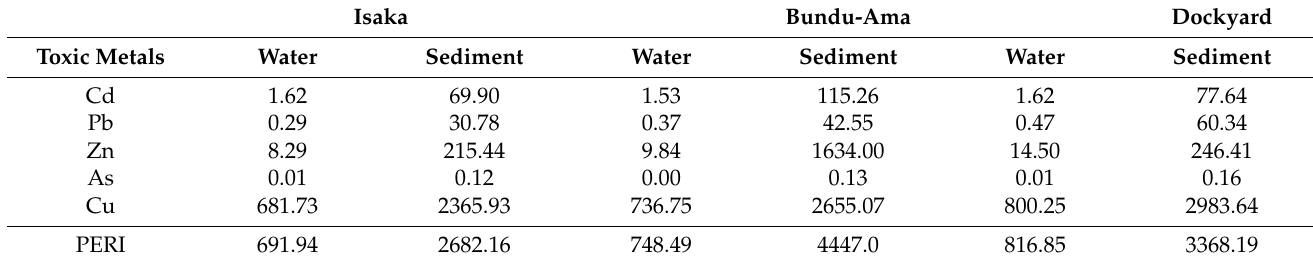
Figure 2. Heavy metals’ potential ecological risk index (PERI) in the Isaka–Bundu tidal mangrove swamp. ( a ) The PERI values recorded for water in all the stations; ( b ) The PERI values recorded for sediment in all the stations. Table 4. Ecological risk factor and the potential ecological risk index (PERI) of the toxic metals in the Isaka–Bundu tidal mangrove